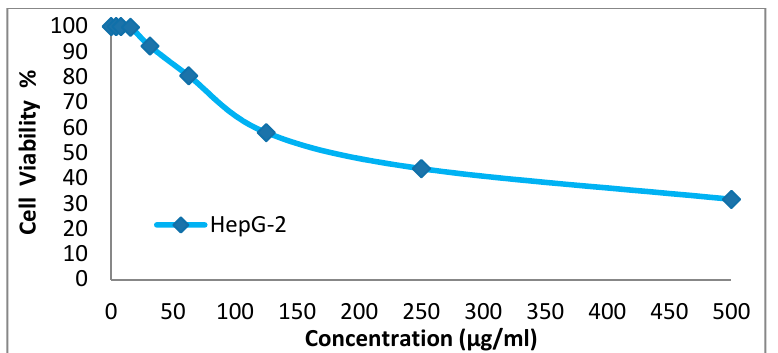
Figure 6. Evaluation of disperse dye 14x on cell line A-549.